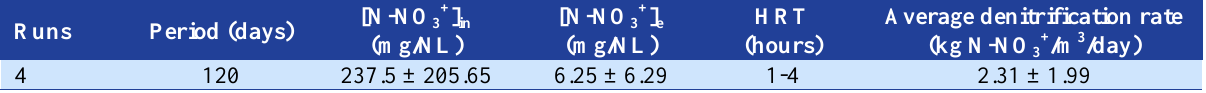
Table 2. Operational parameters for the DGAC-USR throughout this study Runs Period (days)